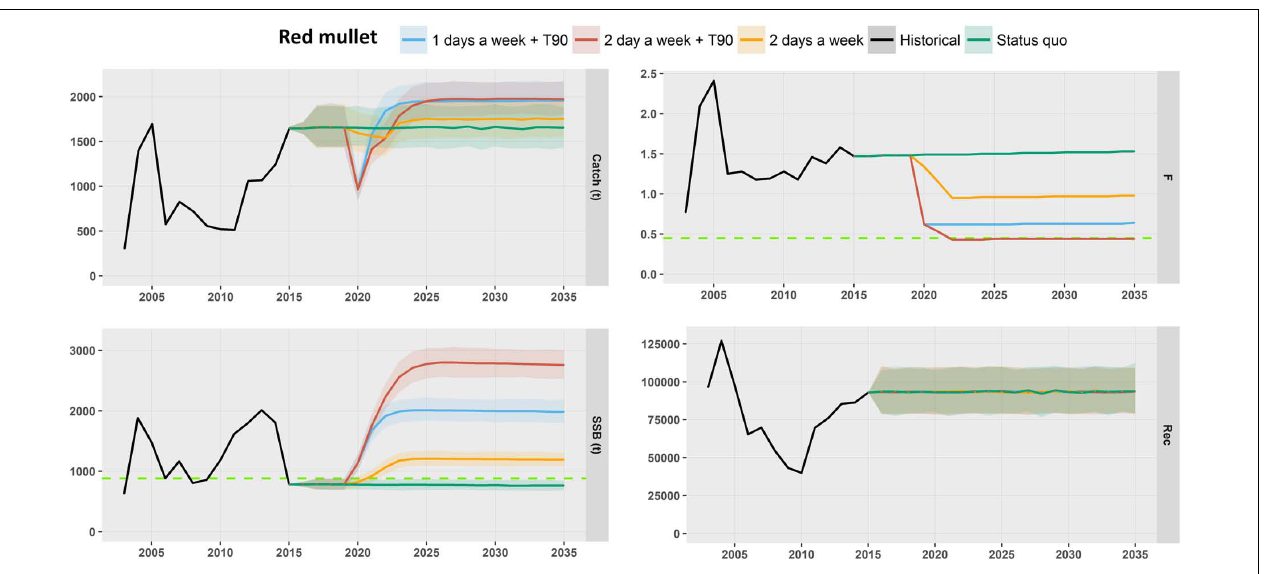
FIGURE 12 | Results of the bioeconomic model of catch (tn), fishing mortality (F 1 − 3 ), SSB (tn), and constant recruitment for M. barbatus under historical series and Scenario 0: status quo ; Scenario 6: 40% effort reduction; Scenario 7: selectivity change plus 20% effort reduction; and Scenario 8: selectivity change plus 40% effort reduction. Dashed lines indicates the FMSY level and SSBlim (computed as SSBlim = 1.4*SSBmin , where SSBmin is the minimum value of SSB observed in the historical data